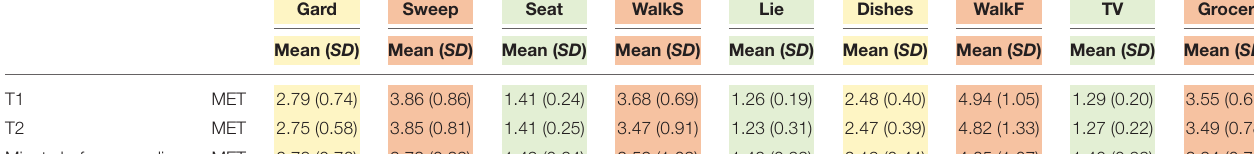
FIGURE 1 | SVM vs. METs for the dominant (left) and non-dominant (right) wrists. Each point represents one activity and one participant. Timepoint 1 and 2 are shown in blue and red, respectively. TABLE 2B | MET values for the nine activities and both timepoints, average (SD) and 95% CI across 31 participants, compared to the MET values for the same activities, in the minute prior to the recording period. Gard